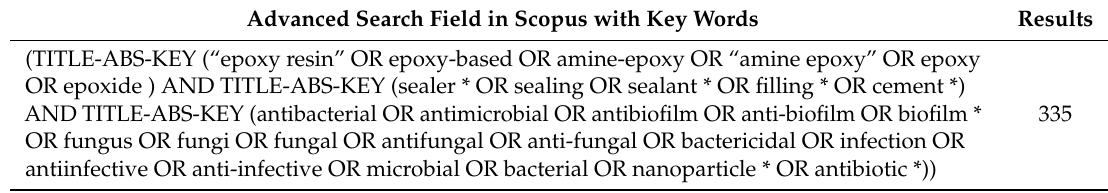
Table 2. Search strategy with the keywords used in Scopus